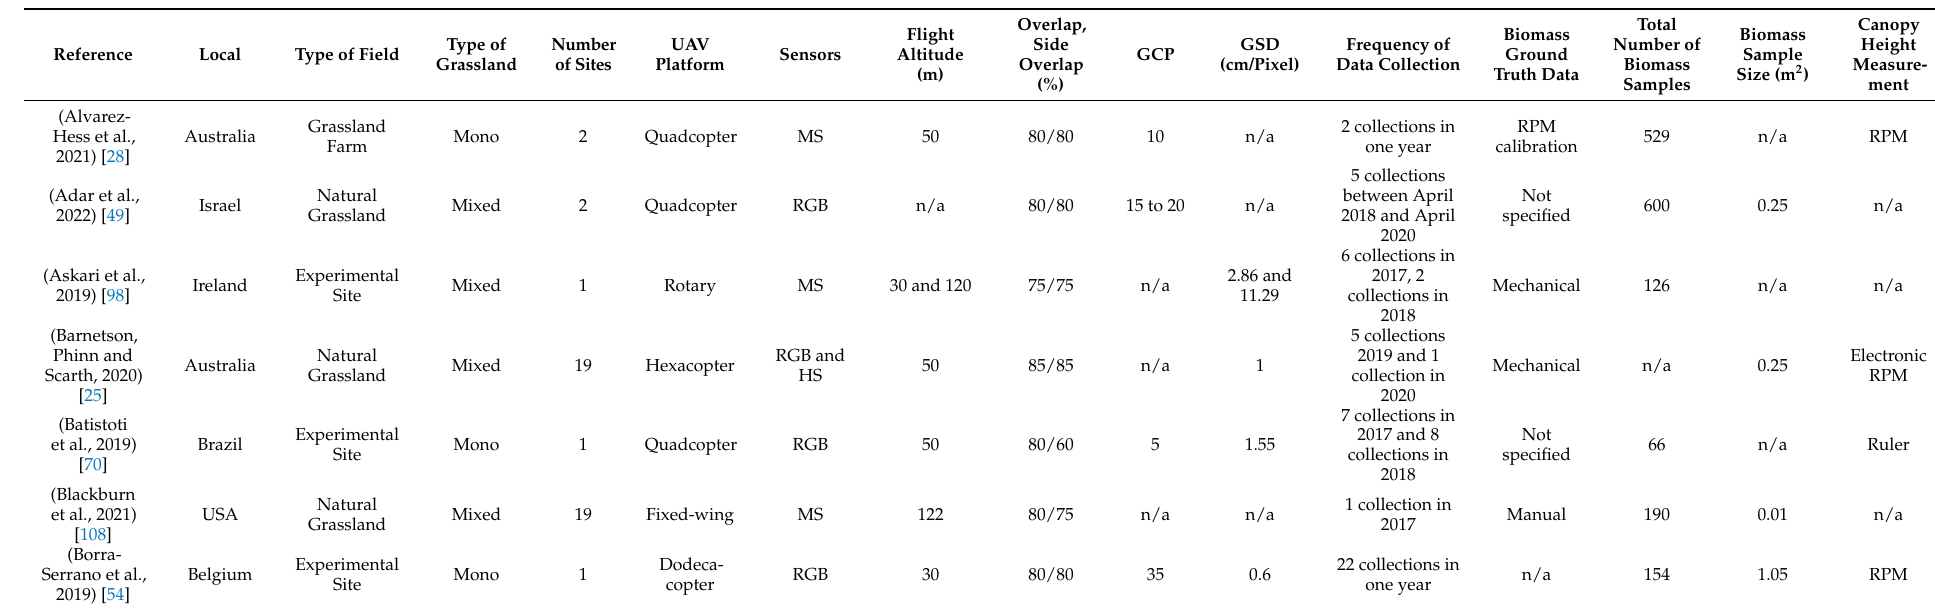
Table A2. A summary of data field collection from papers assessed in the